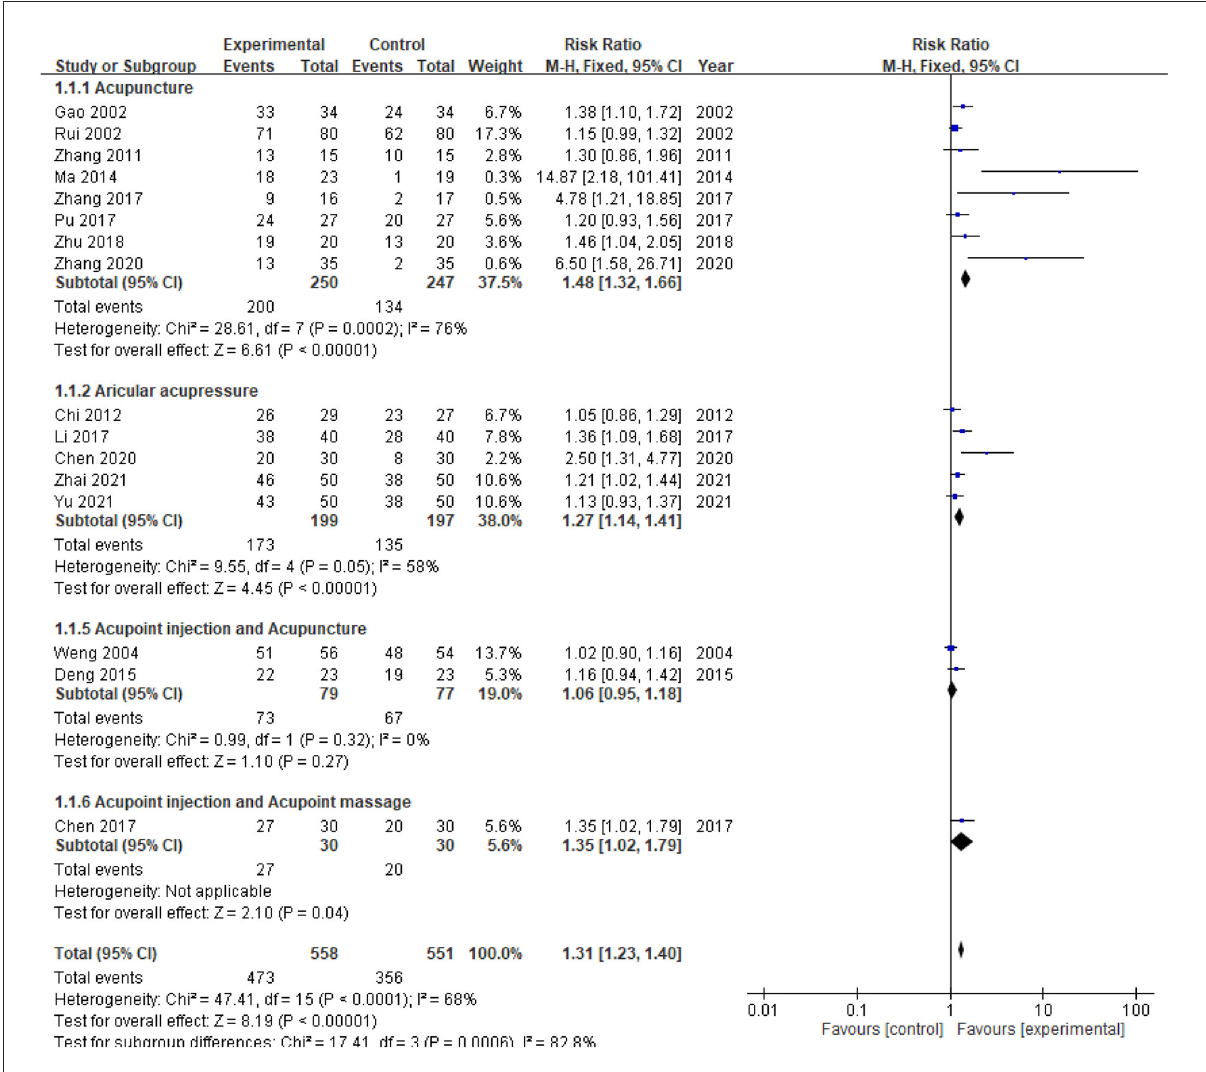
FIGURE4 Forest plot comparison of effective rates in patients with uremic pruritus treated with acupuncture or related therapies. CI, confidence interval; df, degrees of freedom; M-H,